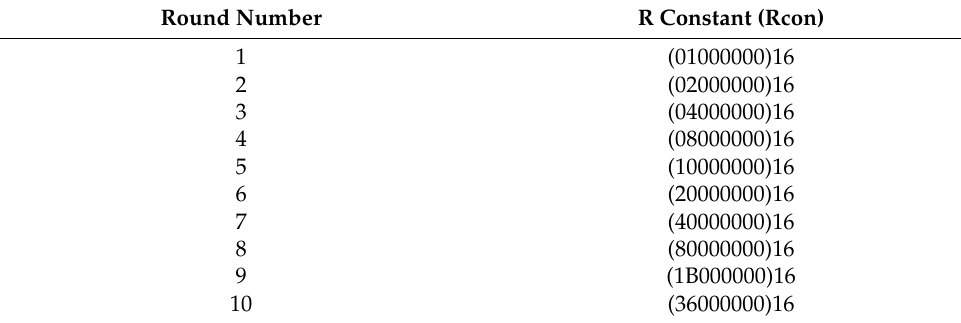
Table 2. R constant values for each rounds of